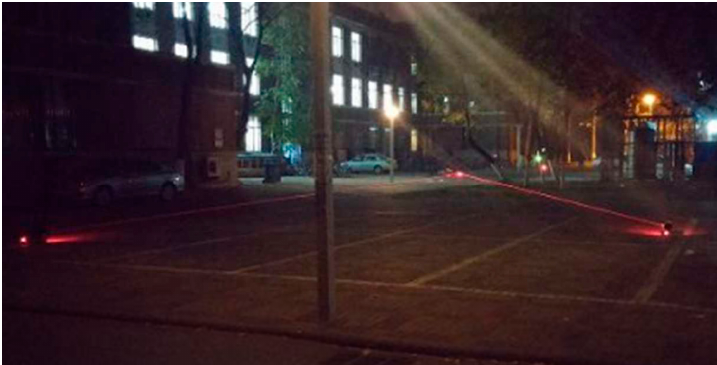
Figure 22. Test environment in foggy and dark night.